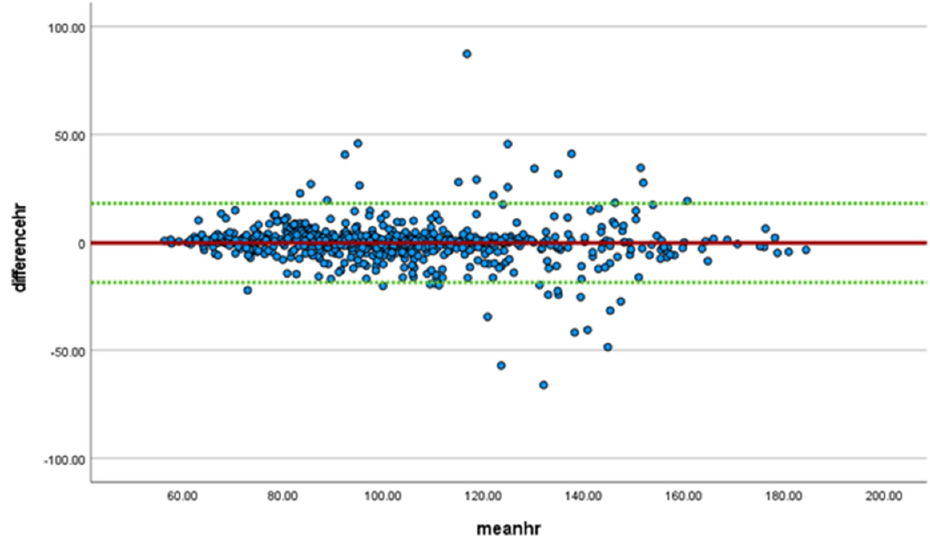
Figure 2. Bland-Altman Plot for heart rate comparing SS to Polar 10. Mean noted in red, 95% Figure 2 . Bland-Altman Plot for heart rate comparing SS to Polar 10 . Mean noted in red, 95% confi- confidence interval in green. dence interval in green. Table 3. Correlation and percentage difference of heart